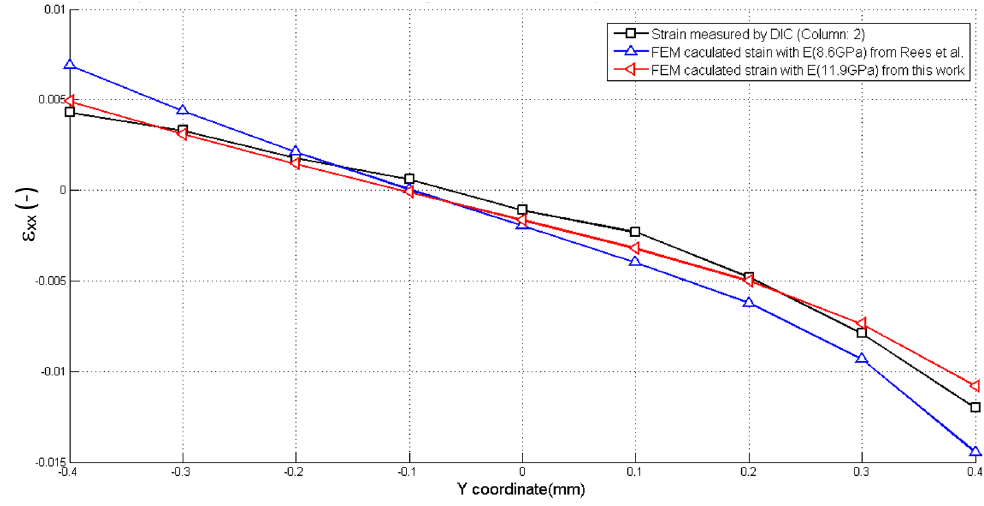
between FEM and DIC along the y xx